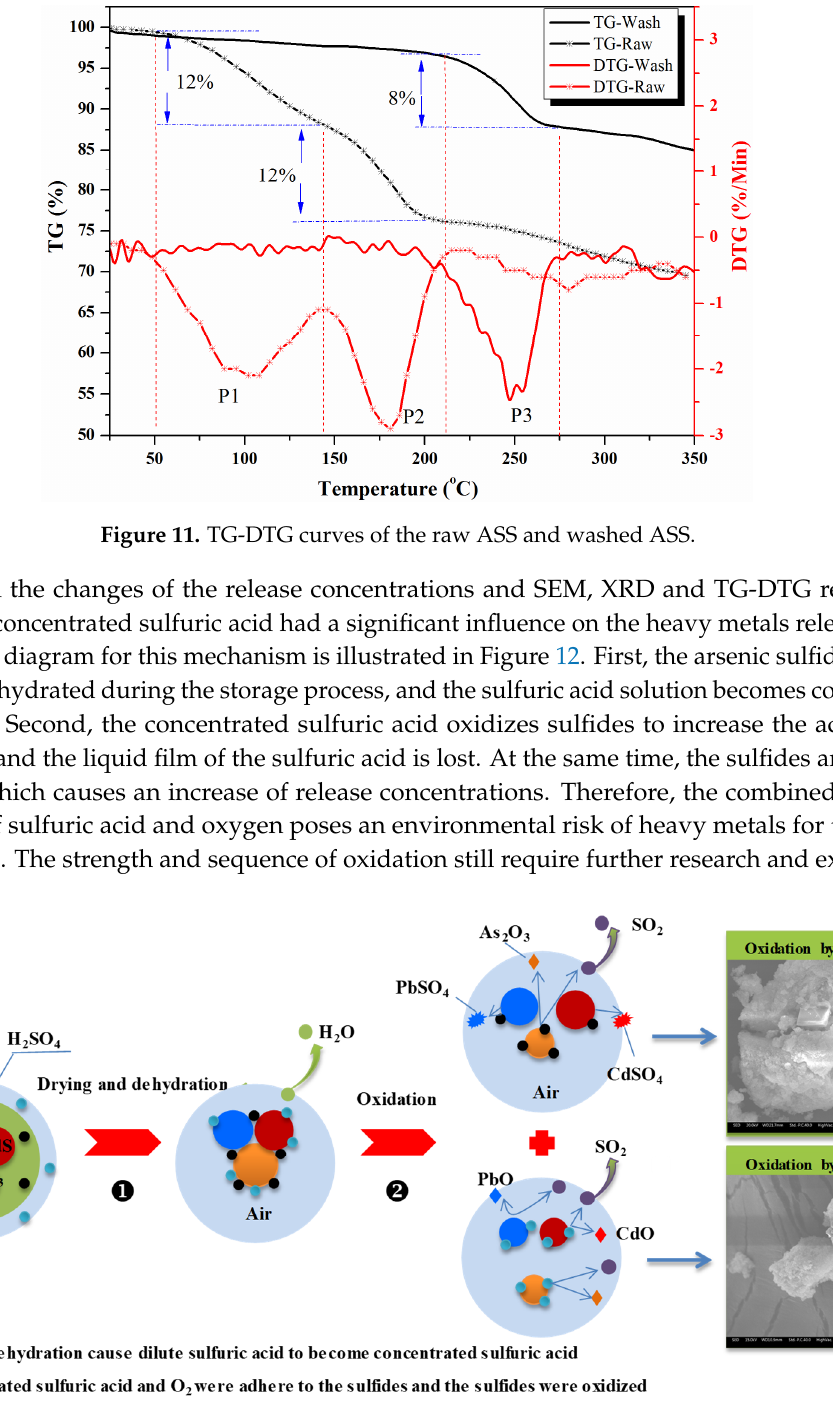
Figure 12. Schematic illustration of the simulated storage procedure.